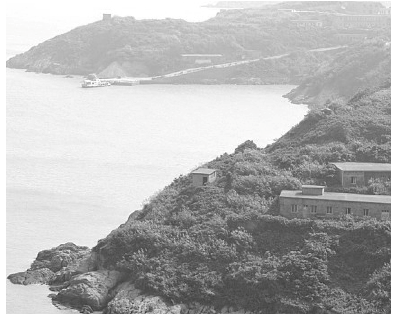
Figure 1. Test site in Yushan Island.